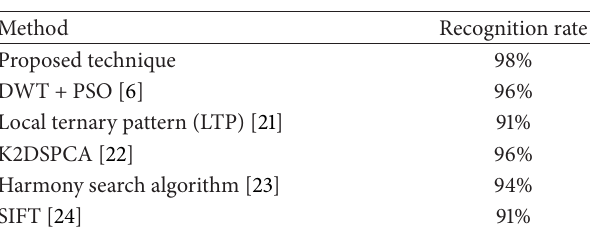
Table 3: Proposed technique comparison with existing techniques.